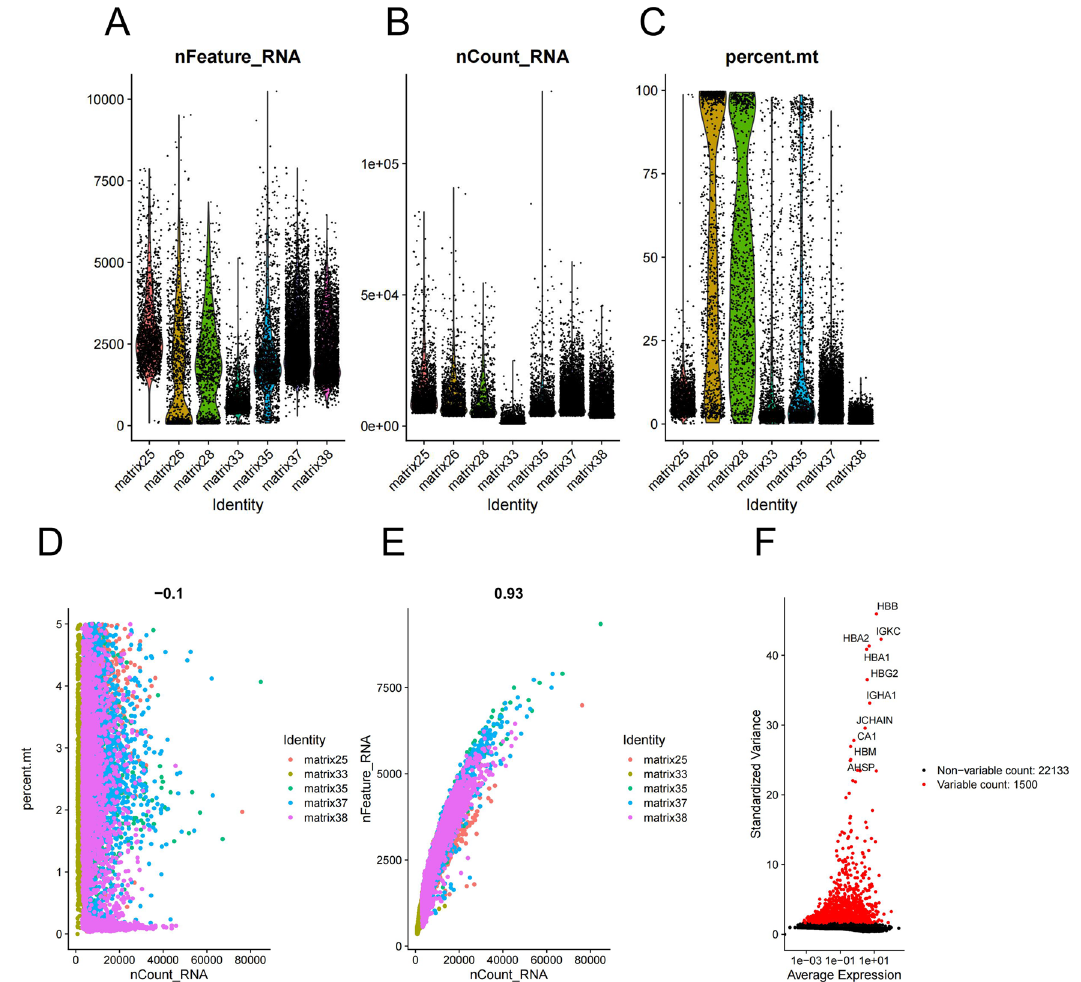
Figure 1. Quality control and filtering of scRNA-seq data. ( A ) The number of genes detected in 7 ccRCC samples. ( B ) Sequencing depth in each sample. ( C ) Content of mitochondria genes in each sample. High levels meant low cell activity. ( D ) A negative correlation between sequencing depth and mitochondrial gene content in 5 retrieved samples (R = −0.1). ( E ) A positive correlation between sequencing depth and total intracellular sequences in 5 retrieved samples (R = 0.93). ( F ) Volcano plot illustrated genes fluctuating in all samples. The first 1,500 genes marked in red had high variations, and the names of the top 10 genes are presented. Our scRNA-seq data is from GEO database (https:// www. ncbi. nlm. nih. gov/ geo/ query/ acc. cgi? acc= GSE15